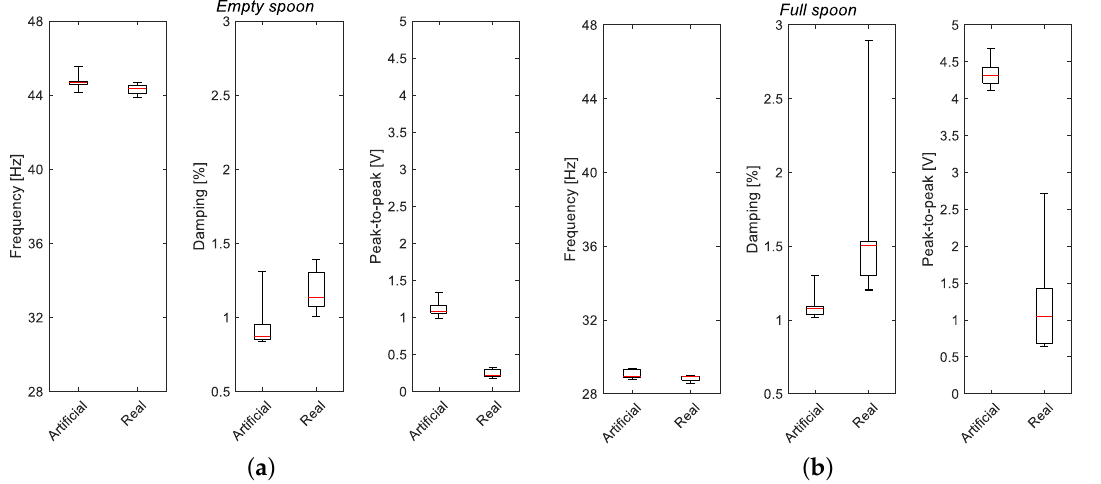
Figure 5. Box plots representing the four quartiles and the median (in red) of the frequency, damping ratio, and peak-to-peak voltage registered in indoor (with artificial rain) and outdoor (with real rain) tests. ( a ) empty spoon, ( b ) full